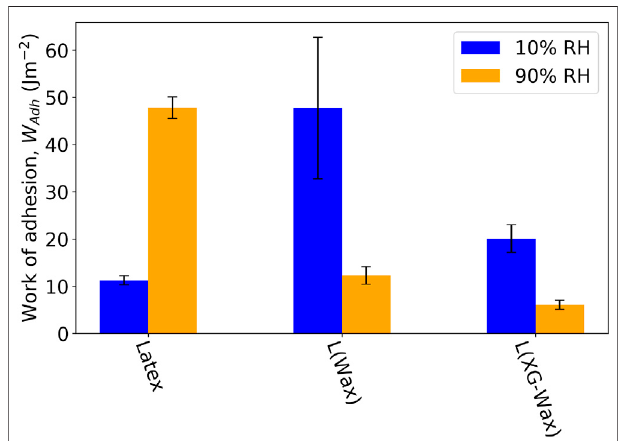
FIGURE 10 | Average W Adh for Latex, L (Wax), and L (XG-Wax) at 20 ° C atarelativehumidityof10and 90%.Theerrorbars indicatethestandarderror in the mean W Adh value.